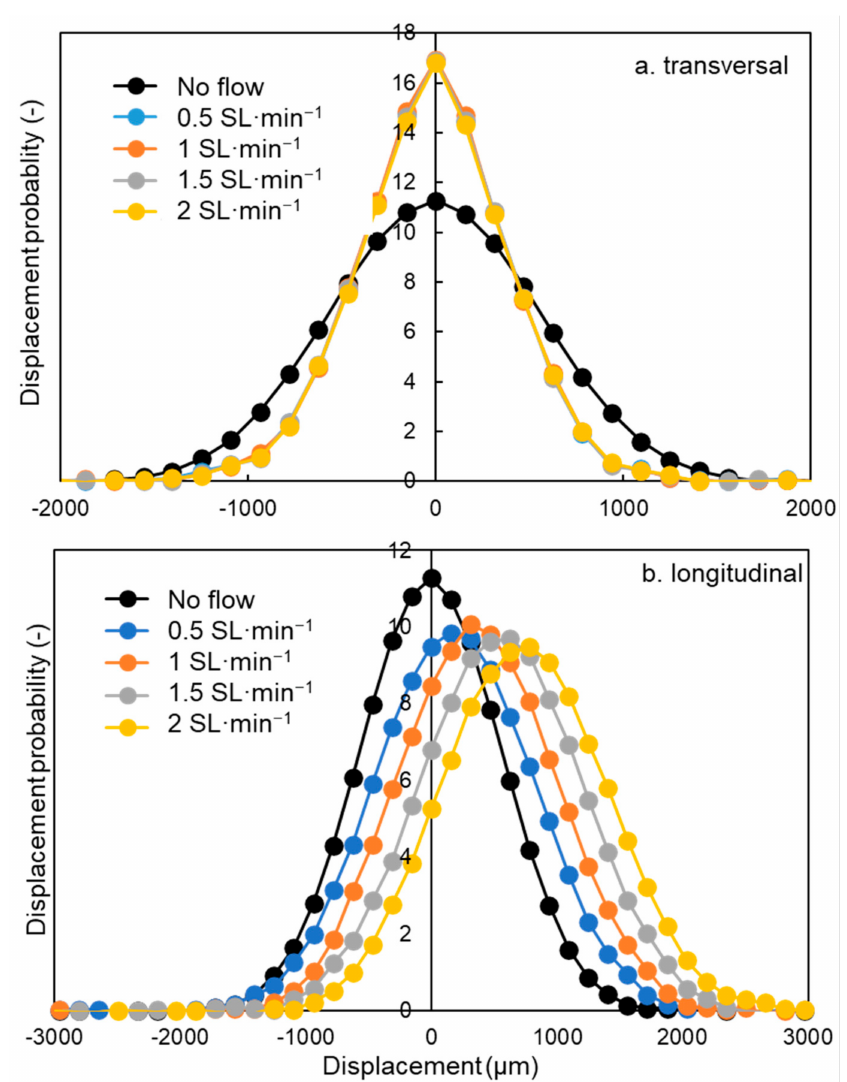
Figure 6. Transversal ( a ) and longitudinal ( b ) gas propagator in the commercial monolith channels. The results in Figure 6b are superimposed with the propagator of self-diffusing methane gas as a reference to compare the displacement probability function of the gas. Additionally, dispersion coefficients were computed by relating the full-width at half- (cid:16) (cid:17) ∆ − δ in each probability function: maximum ∆ 1/2 to the observation time PFG 3